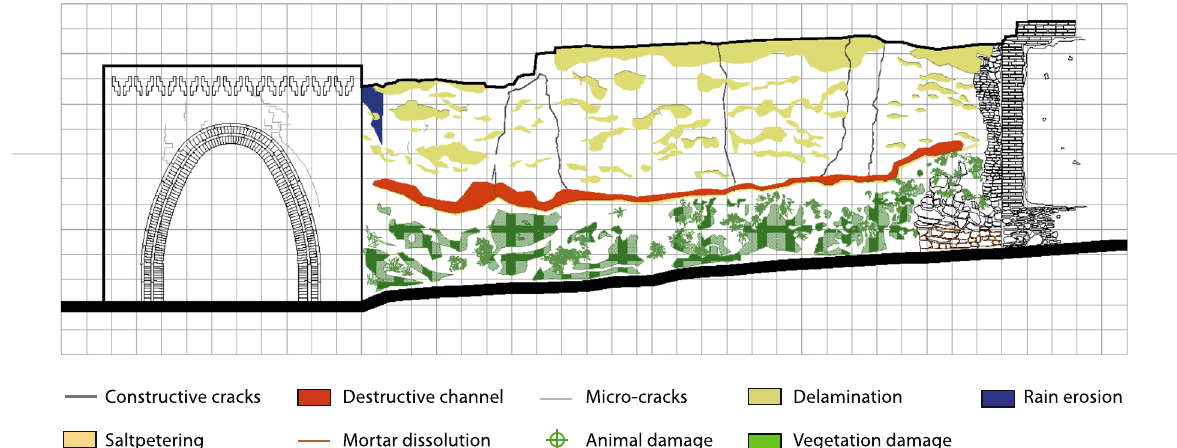
Fig. 17 Pathological analysis of the north facade of the wall (Source: Tongji University, Ecole de Chaillot and China Academy of Art